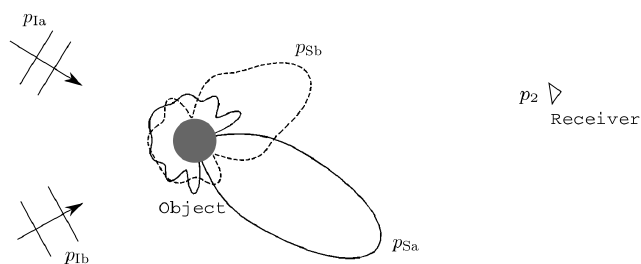
Figure 1. Two primary incident fields p Ia and p Ib at respective angular frequencies ω a and ω b are incident on an object, causing two primary scattered fields, p Sa and p Sb . A receiver at r R measures the second order field p 2 ( r R , t )